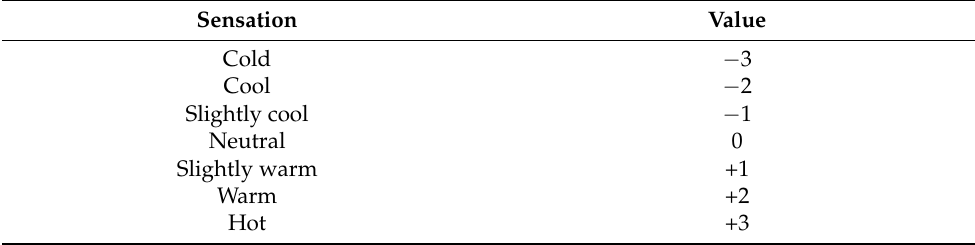
Table 7. PMV scale.